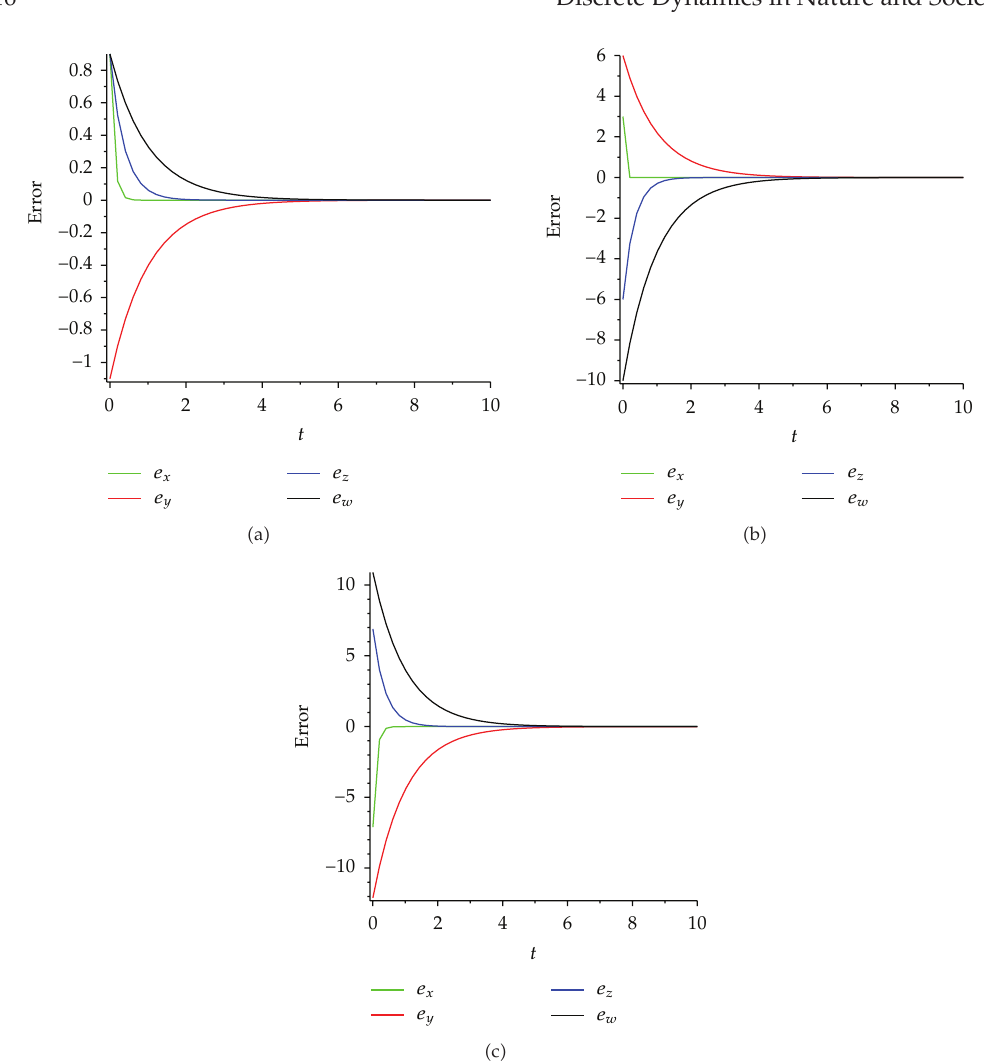
Figure 15: (cid:6) a (cid:7) It shows that the behaviour of the trajectories e x ,e y ,e z , and e w of the hyperchaotic Lorenz system error system tends to zero as t tends to 5 when the scaling factor α (cid:8) 1. (cid:6) b (cid:7) It shows that the behaviour of the trajectories e x ,e y ,e z , and e w of the hyperchaotic L¨u system error system tends to zero as t tends to 5 when the scaling factor α (cid:8) 1. (cid:6) c (cid:7) It shows that the behaviour of the trajectories e x ,e y ,e z , and e w of the error system between hyperchaotic Lorenz system and hyperchaotic L¨u system tends to zero as t tends to 5 when the scaling factor α (cid:8)